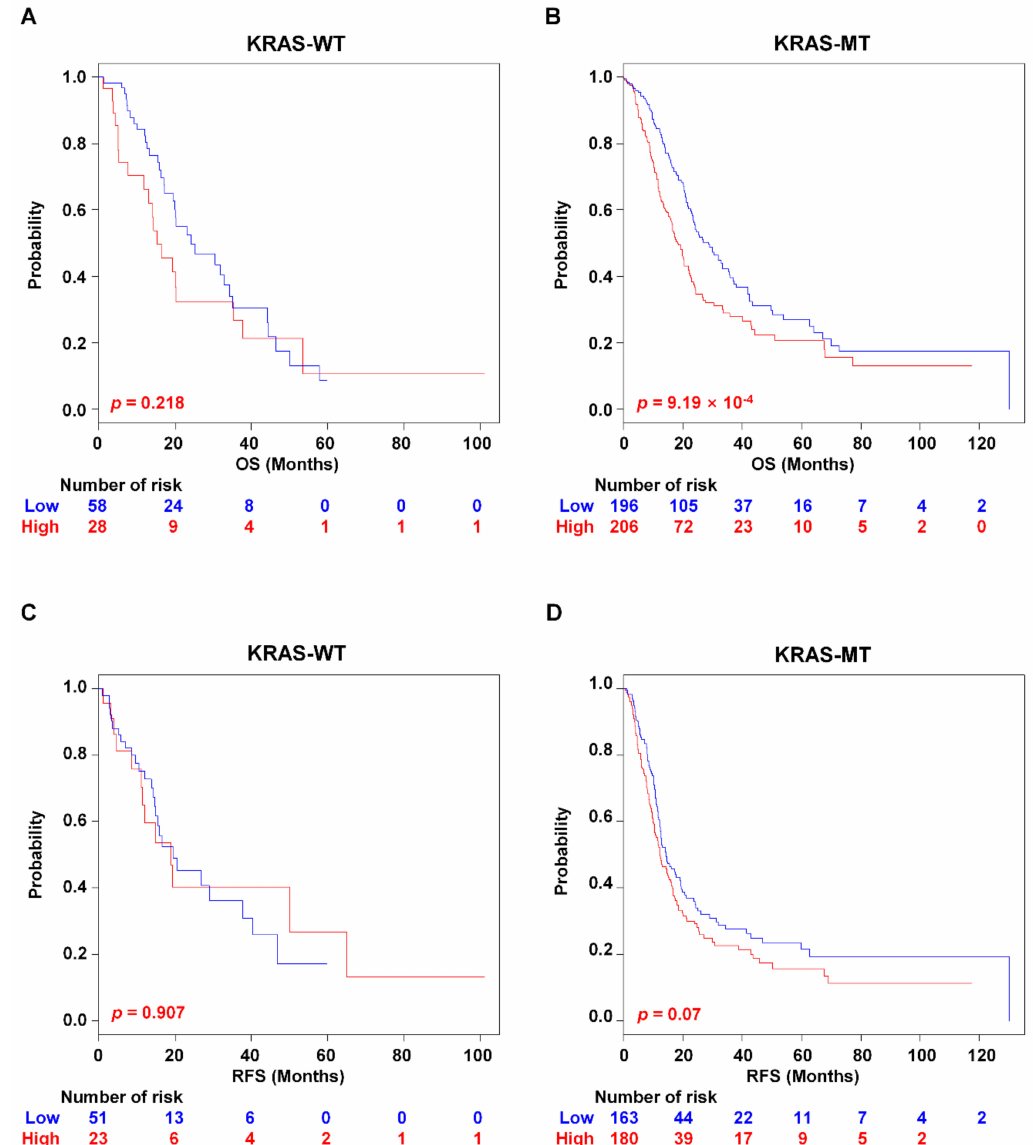
Figure 8. Kaplan–Meier survival analysis of PAC-5 gene signature with KRAS mutation. Kaplan–Meier survival analyses were used to estimate di ff erences in OS and RFS between the low- and high-risk groups with KRAS status. ( A , B ) Kaplan–Meier plots for OS of two risk-subgroups. ( C , D ) Kaplan–Meier plots for RFS of two risk-subgroups. KRAS-WT, wild type KRAS; KRAS-MT, mutant KRAS. p -Values were computed by the log-rank